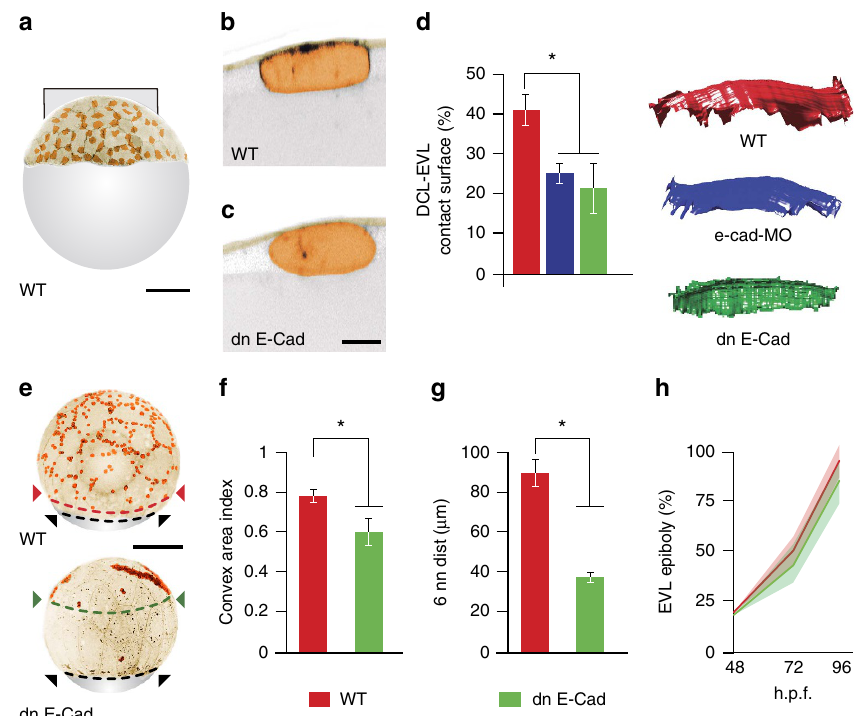
Figure 3 | Adhesive interactions between the DCL and EVL during tissue spreading. ( a ) Confocal microscopy z -stack maximum projection showing a lateral view of an A. nigripinnis embryo expressing GAP43-EGFP , with animal to the top, showing the distribution of DCL cells at 40% epiboly. ( b , c ) High-magnification confocal microscopy sections showing adhesive contacts established between the DCL and the EVL basal surface in the WT ( b ) and after functional abrogation of E-cad through the injection of dn E-cad ( c ). ( d ) Quantification of the DCL-EVL contact area (left), with corresponding examples of 3D volumetric projections (right), for the experimental conditions depicted in b and c ( n ¼ 6 cells per condition). ( e ) Confocal microscopy z -stack maximum projections showing lateral views of WT (top) and dn E-cad (bottom) embryos at 80% epiboly. Dashed lines indicate the advancement of the margin of the EVL (black) and DCL (red and green for WTand dn E-cad conditions, respectively). The look-up table of images in a – c and e has been inverted. EVL and DCL cells are pseudocoloured in light brown and orange, respectively. ( f , g ) Quantification of the total covered area ( f ) and mean distance to the six nearest neighbours ( g ) for the DCL in WTand dn E-cad embryos. ( h ) Temporal progression of the EVL margin at different stages of epiboly in WTand dn E-cad embryos. Values in plots ( f – h ) are expressed as means ± s.e.m. ( n ¼ 8 embryos per condition). * P o 0.001 ( t -test). Scale bar, 30 m m ( b , c